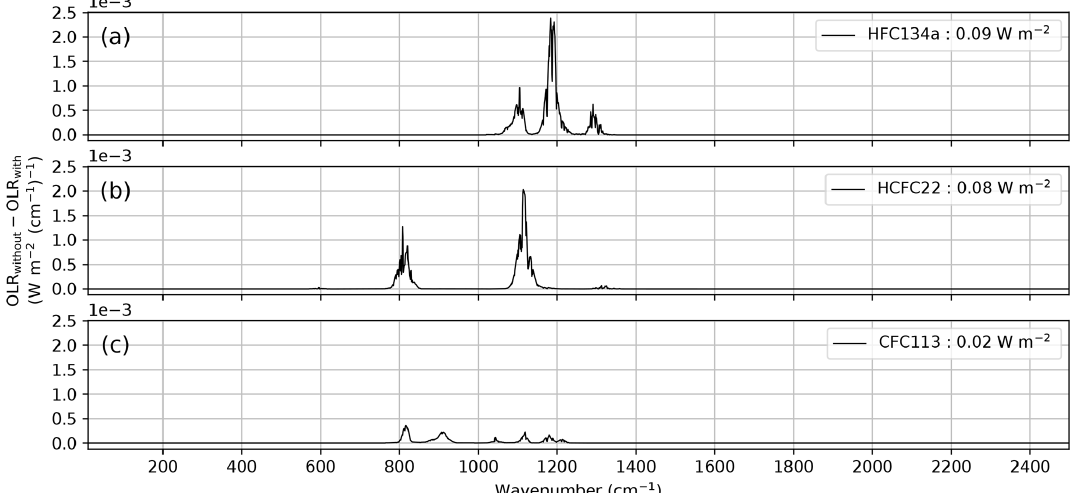
Figure 6. Spectral OLR variation due to a complete removal of atmospheric HFC134a (a) , HCFC22 (b) , and CFC113 (c) calculated from the TIGR mean Tropical atmosphere. The total longwave OLR variations are reported in the legends. Note that the y axis ranges from 0 to 2.5 × 10 − 3 Wm − 2 ( cm − 1 ) − 1